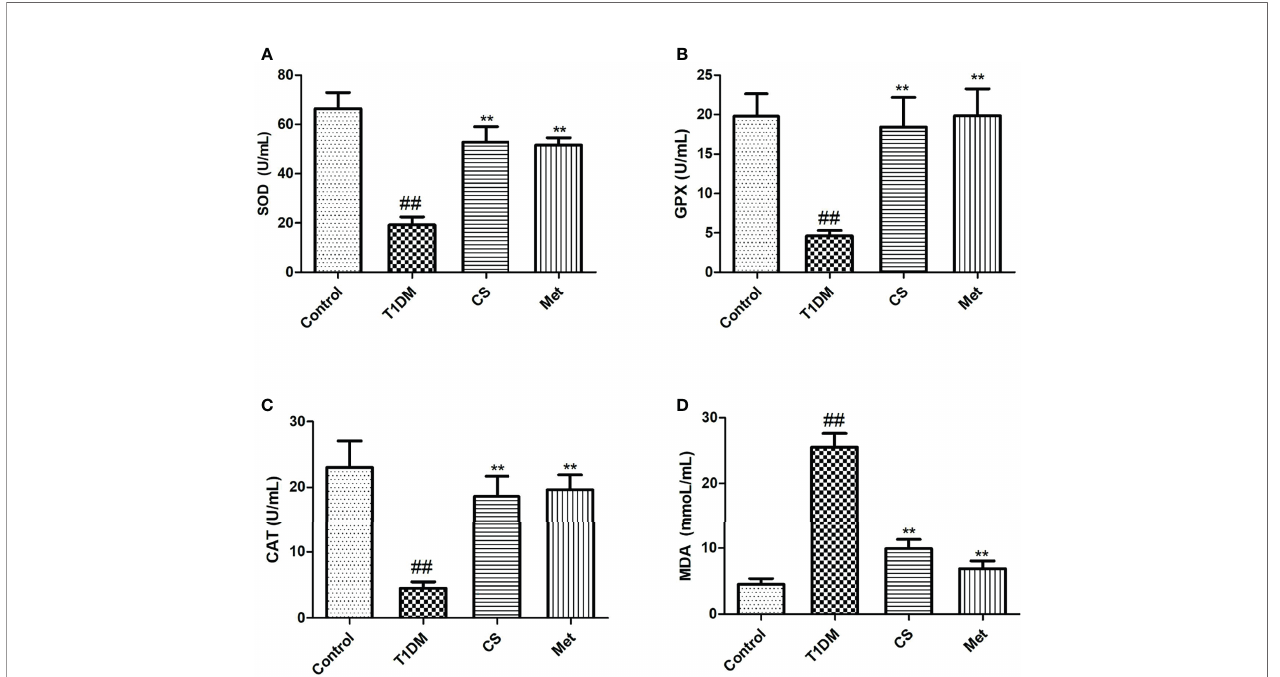
FIGURE 5 | The level of serum oxidative stress parameters in different groups at the end of the 10th week. (A) The level of SOD activities in different groups. (B) The level of glutathione peroxidase (GPX) activities in different groups. (C) The level of catalase (CAT) activities in different groups. (D) The level of malondialdehyde (MDA) content in different groups; ## indicates p < 0.01 compared with control, **indicates p < 0.01 compared with the diabetic group.